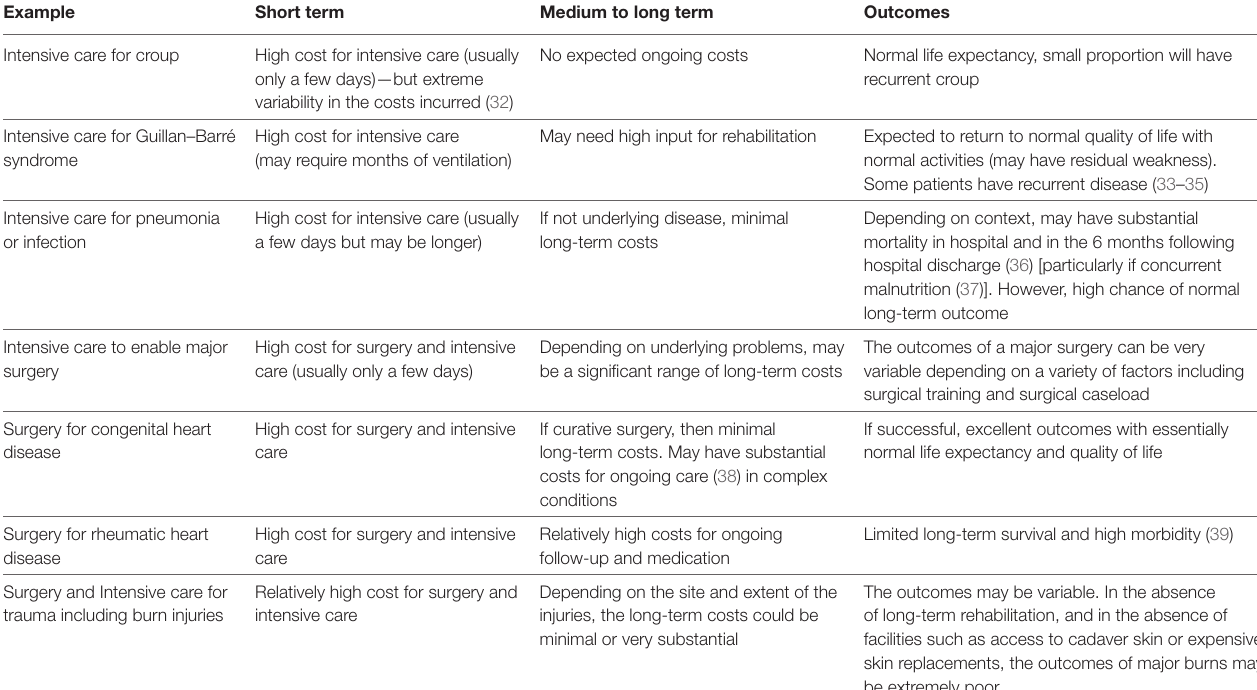
TAbLe 3 | High-cost interventions, cost, and